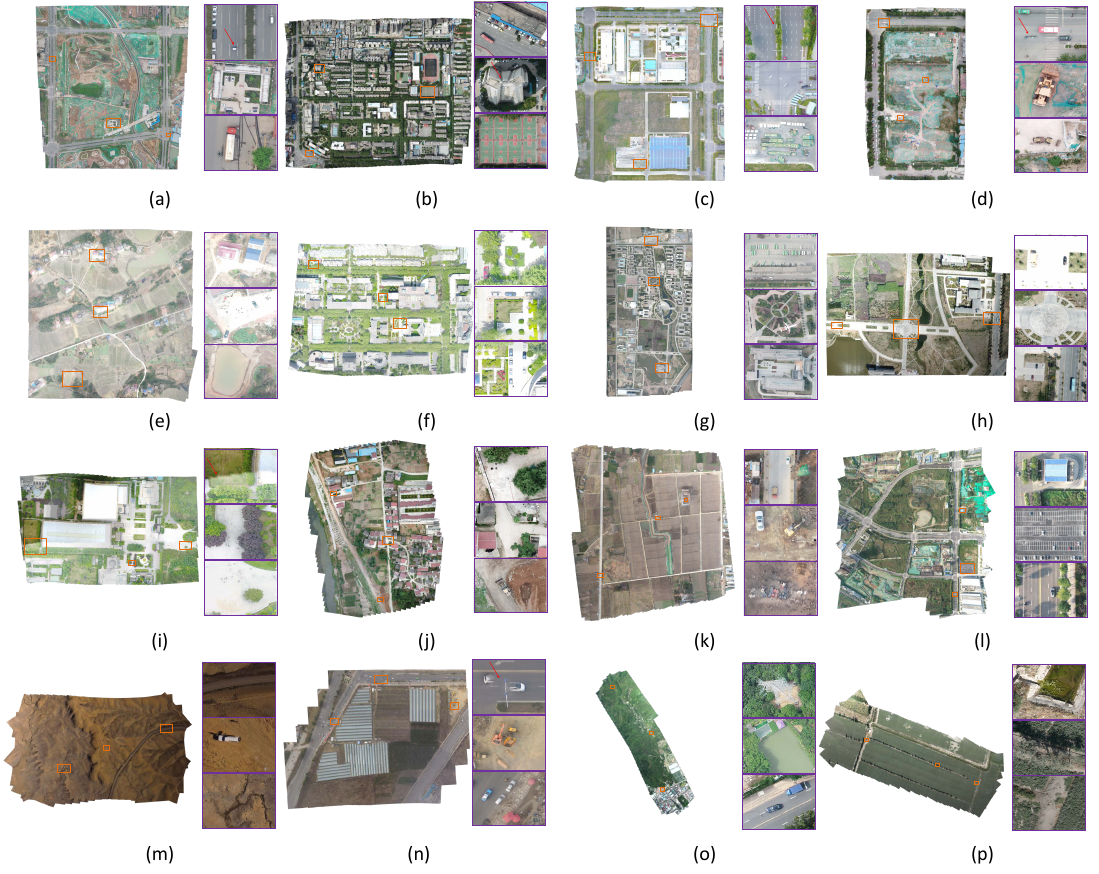
Figure 3. Mosaic results of the proposed method on public NPU DroneMap2 Dataset ( a ) mavic2-road ( b ) mavic-campus ( c ) mavic-factory ( d ) mavic-fengniao ( e ) mavic-huangqi ( f ) mavic-library ( g ) mavic-npu ( h ) mavic-river ( i ) mavic-warriors ( j ) mavic-yangxian ( k ) p4r-field ( l ) p4r-roads2 ( m ) phantom3-olathe ( n ) phantom3-strawberry ( o ) phantom4-mountain ( p ) xag-xinjiang . Some screenshots are highlighted